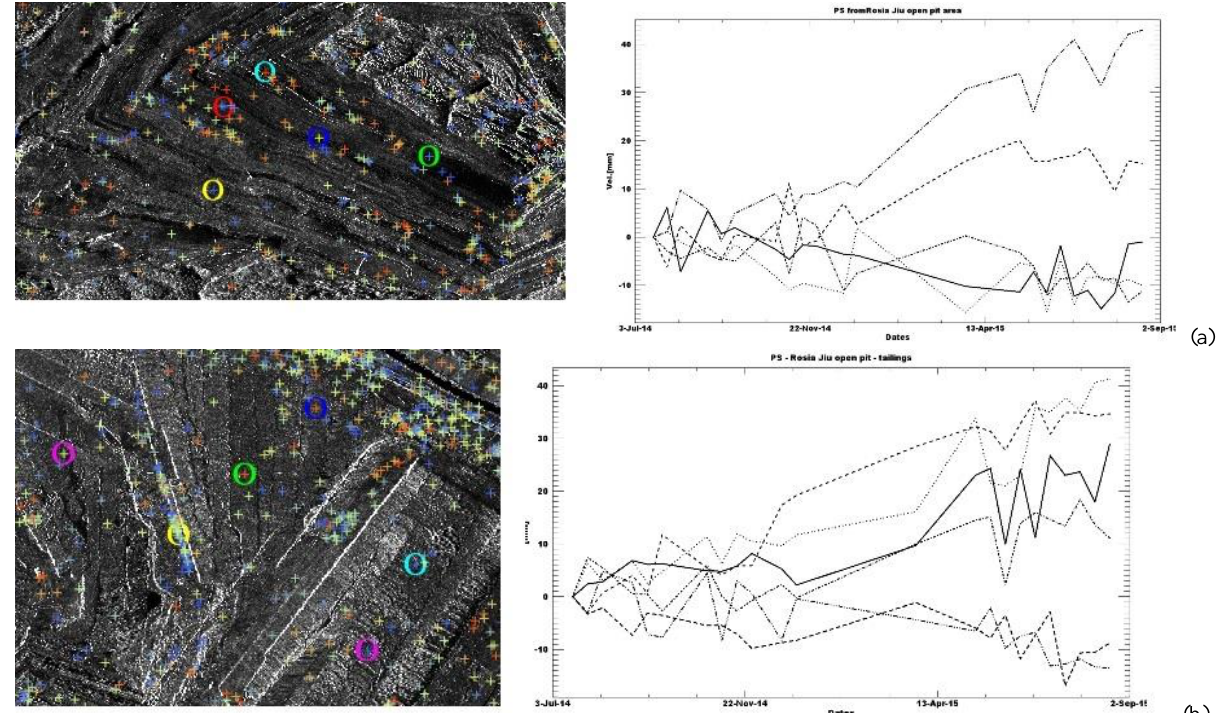
Figure 5. Temporal evolution of the degradation phenomena. (a) PS points’ analysis in the main pit area and (b) PS points’ analysis in the tailing areas. ©DLR, 2014